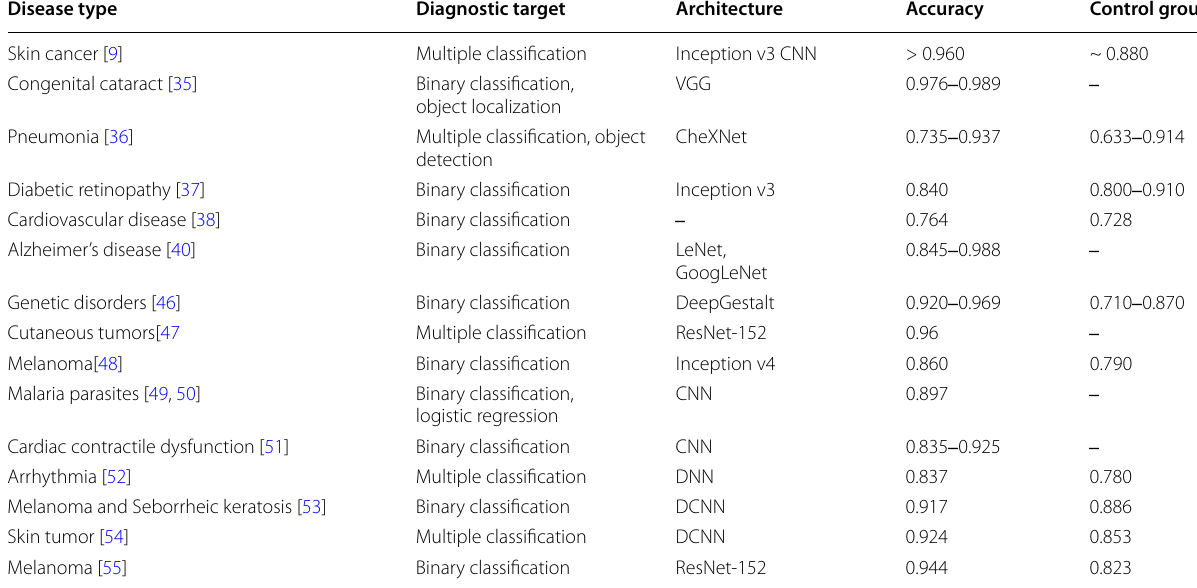
Table 1 Selected applications of deep learning Disease